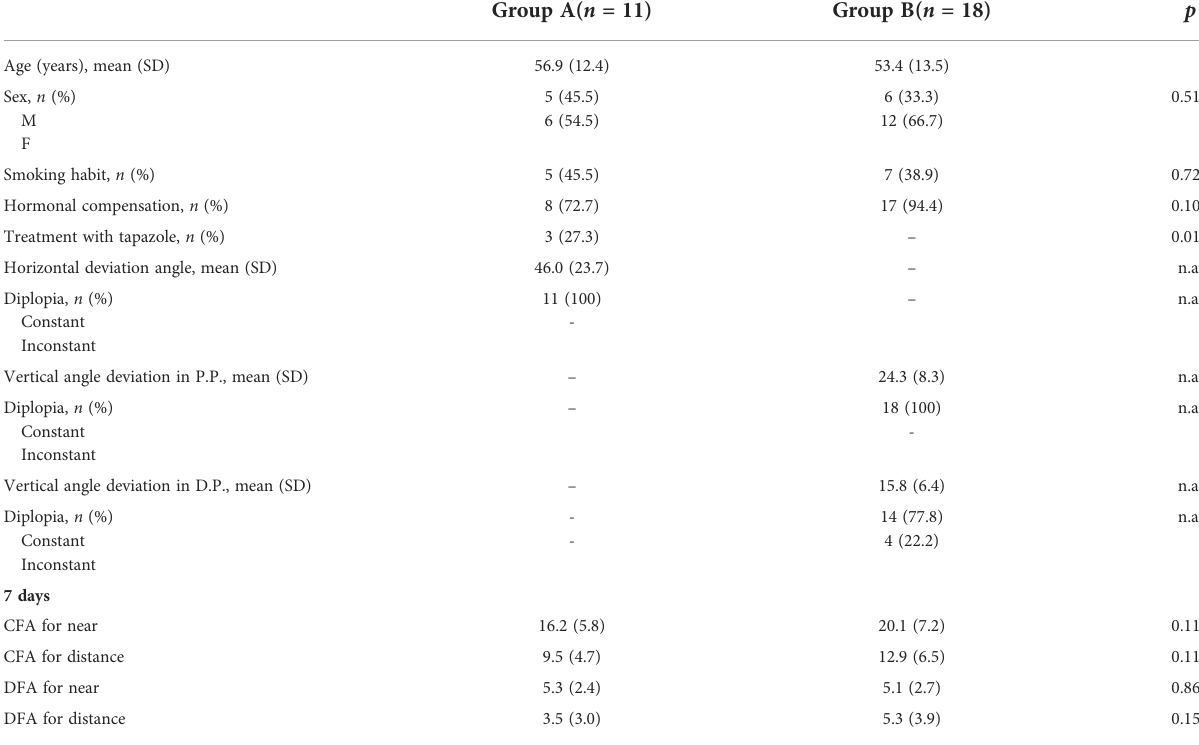
TABLE 1 Baseline general characteristics of the study cohort ( n =